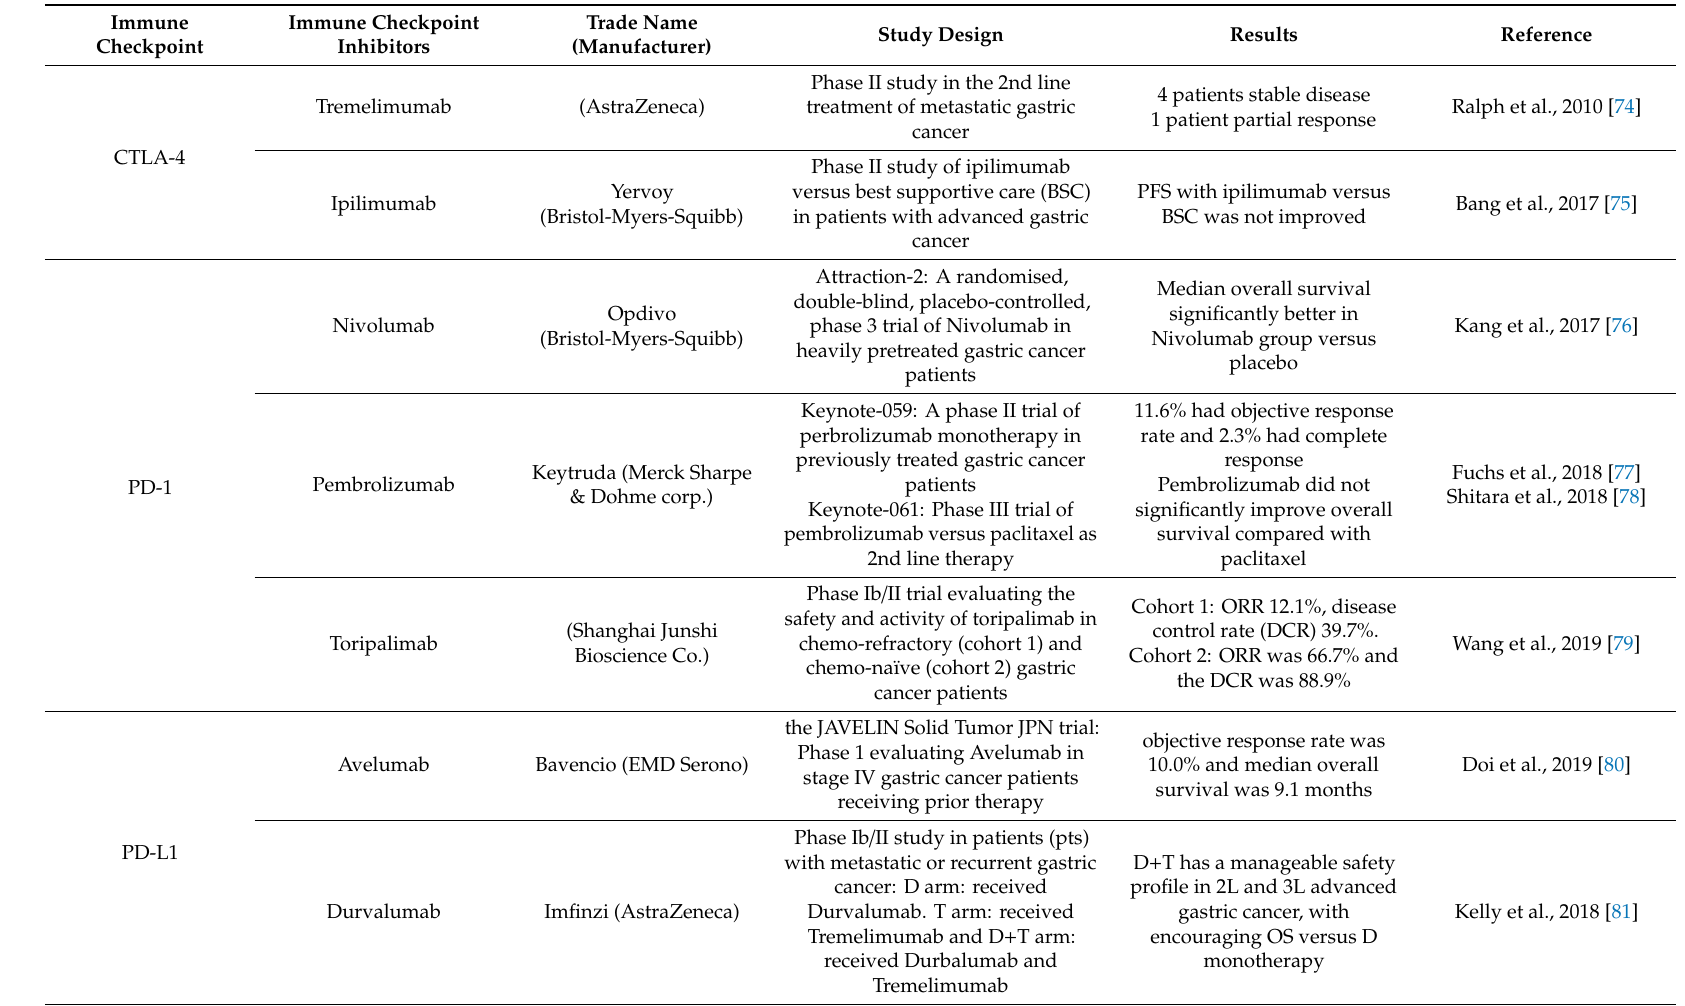
Table 2. Immune checkpoint inhibitors studied in the context of gastric